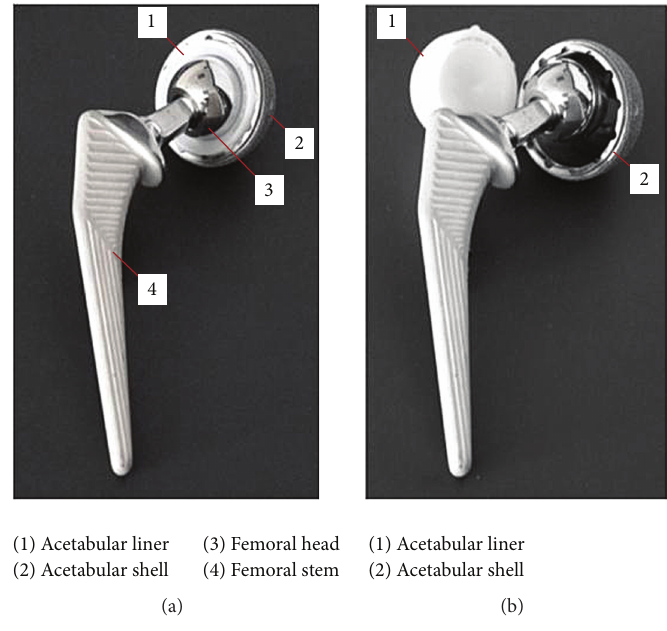
Figure 3: (a) Normal THA implant appearance. The polyethylene liner is well seated within the acetabular shell. (b) Acetabular liner dissociation appearance. The polyethylene liner has clearly migrated from its original position in (a).